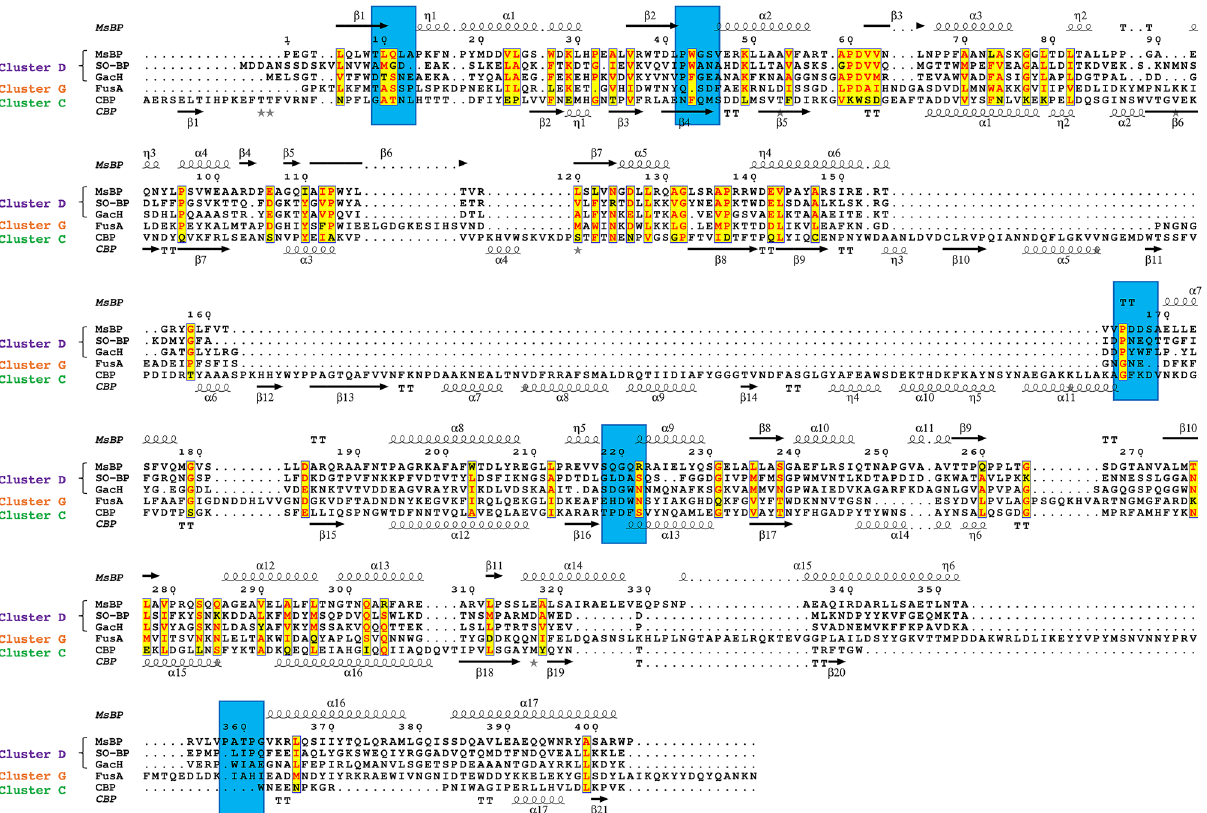
Figure 6. Structural based sequence alignment of MsBP relatives . Sequences of cluster D proteins; SO-BP (PDB ID: 5YSE) 37 and GacH (PDB ID: 3K00); cluster G protein FusA (PDB ID 5G5Y) 69 and cluster C protein CBP (PDB ID 5YQW) are aligned with MsBP sequence. Conserved secondary structure elements forming ligand recognition sites where applicable are highlighted (blue box). Residues with conserved chemistry are shown in yellow. Figure generated with ESPript 71